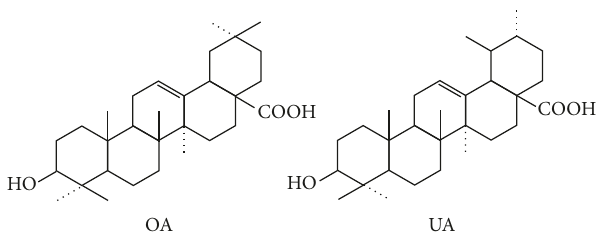
Figure 1: Chemical structures of oleanolic acid (OA) and ursolic acid